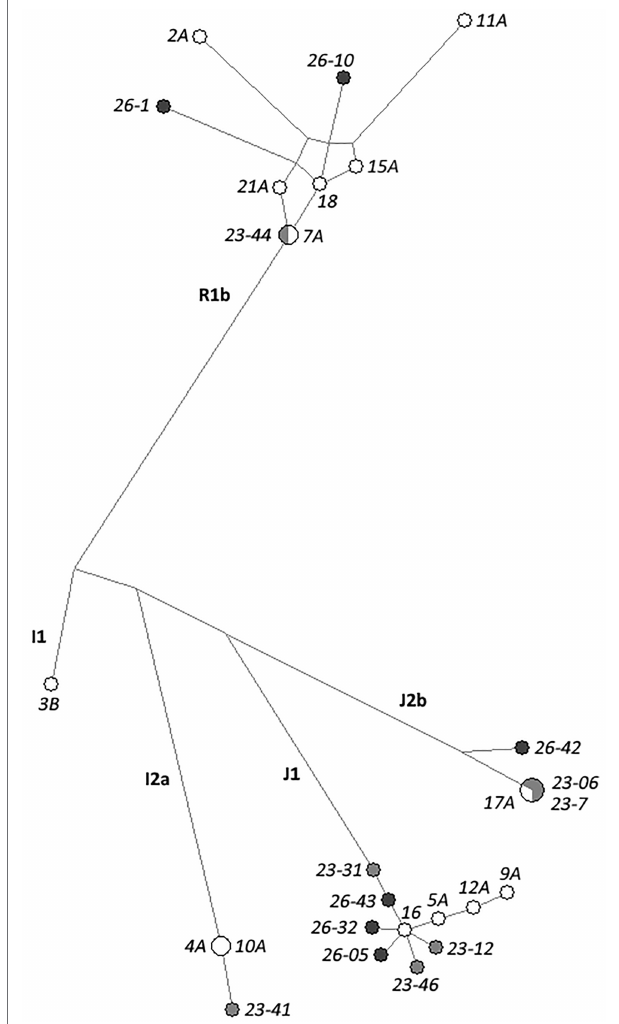
FIGURE 2 | Median Joining (MJ) network analysis of the Y-chromosome haplotypes based on the 27 Yfiler Plus STRs in the 13 ancient and 14 modern samples from Roccapelago. Present-day individuals are highlighted in white dots, ancient mummies from the stratigraphic units SU23 in light-gray and those from the SU26 in dark-gray.